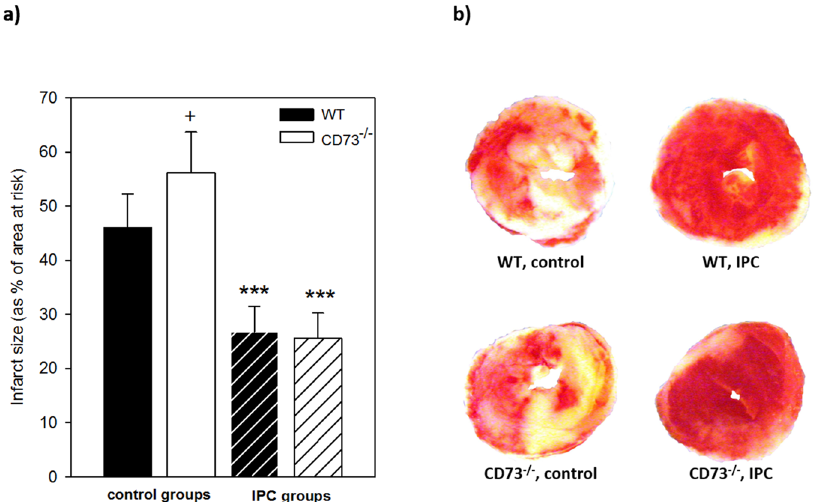
index ischemia in comparison to hearts treated with 3x5 minutes of global ischemic preconditioning (IPC, hatched bars) before the onset of the index ischemia. Control infarct size in CD73 -/- was bigger than in WT (+,